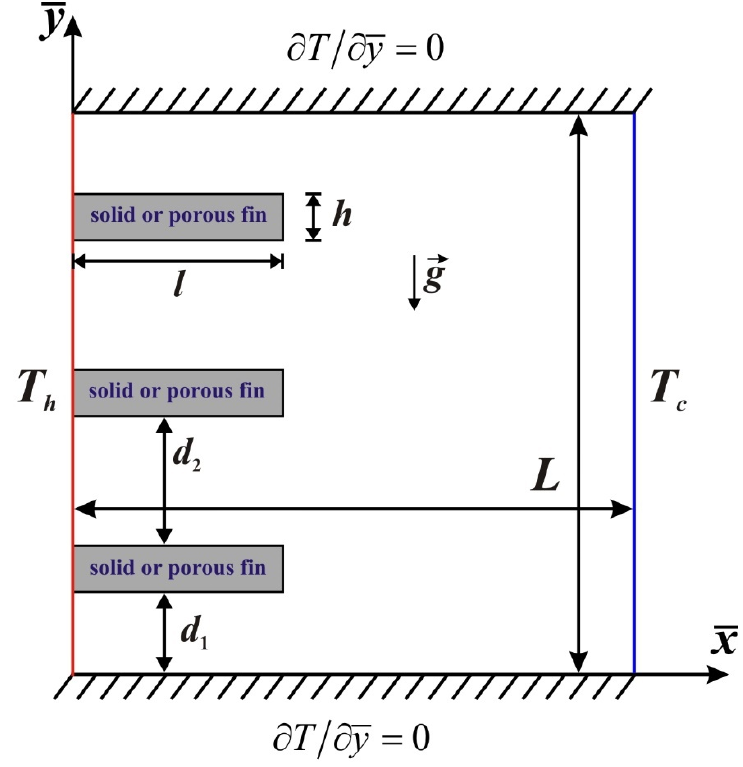
Figure 1. Coordinate system and thermal boundary conditions.